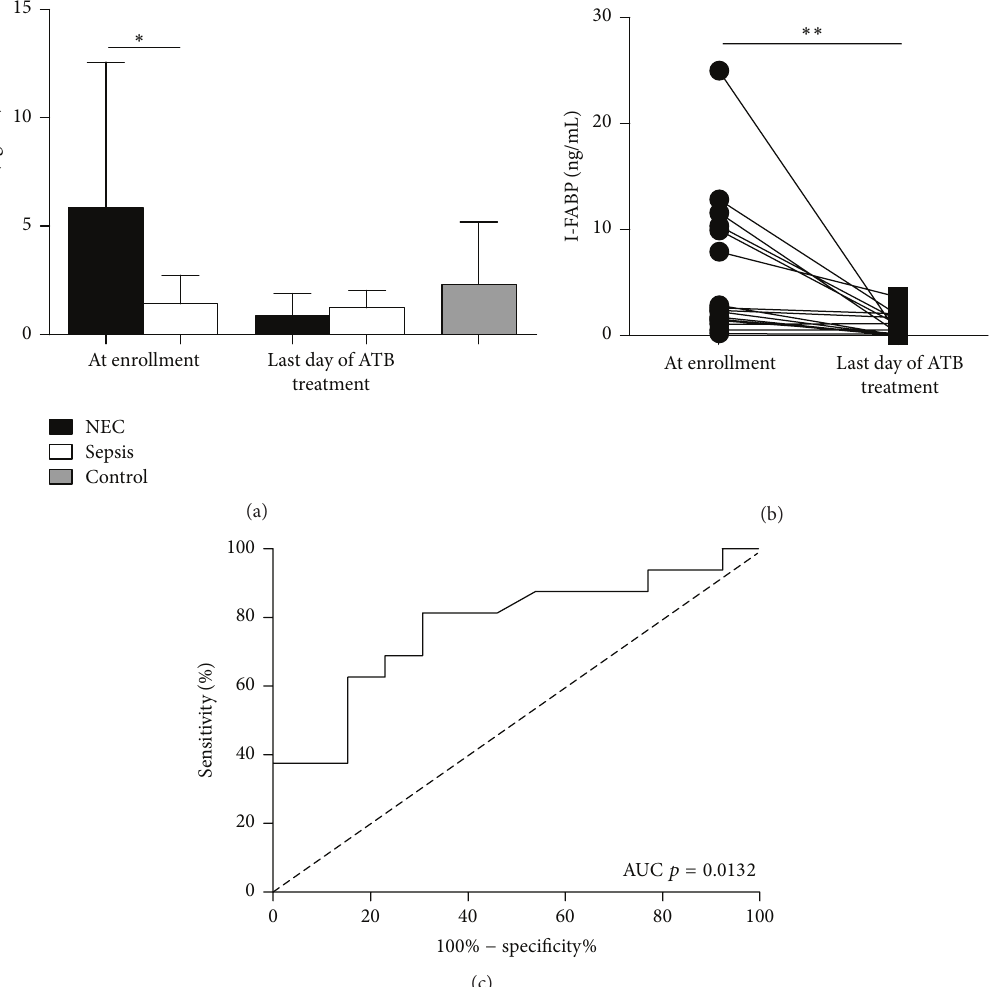
Figure 2: The analysis of I-FABP in serum. (a) The comparison of I-FABP for patients with NEC and sepsis or healthy patients at the time of enrollment ( ∗ 𝑝 < 0.05 , unpaired Student’s 𝑡 -test with Welch’s correction), (b) the comparison of I-FABP in patients with NEC at the time of enrollment and last day of ATB treatment ( ∗∗ 𝑝 < 0.01 , Paired Student’s 𝑡 -test), and (c) the ROC curve analysis using I-FABP levels in NEC and sepsis group at the time of